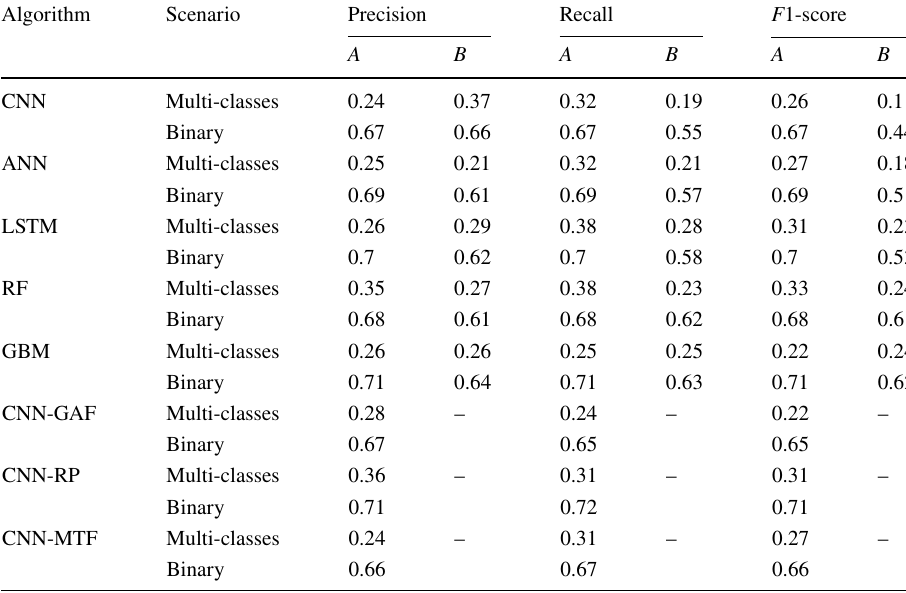
Table 6 Summary of the performance metrics of the